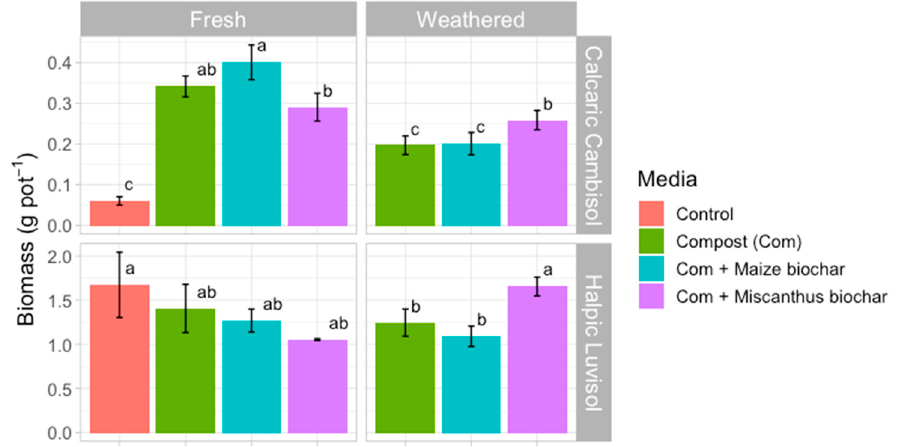
Figure 3. Biomass of ryegrass after addition of compost or its mixture with maize and